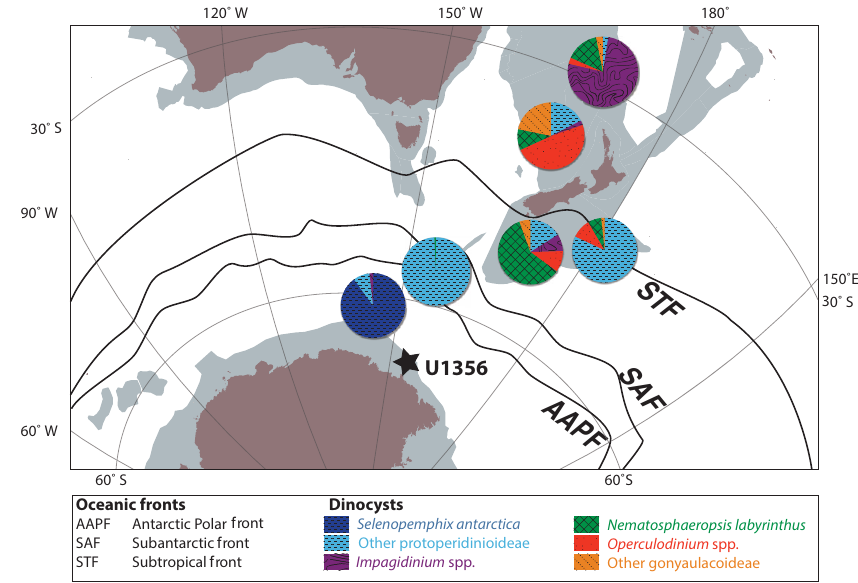
Figure 3. Generic representation of present-day distributions of dinocysts in surface sediments in the Southern Ocean. The dinocyst pie charts represent average dinocyst assemblage compositions for surface sediments underneath oceanic frontal zones in the Southern Ocean. Figure modified from Sangiorgi et al. (2018); data replotted from Prebble et al.